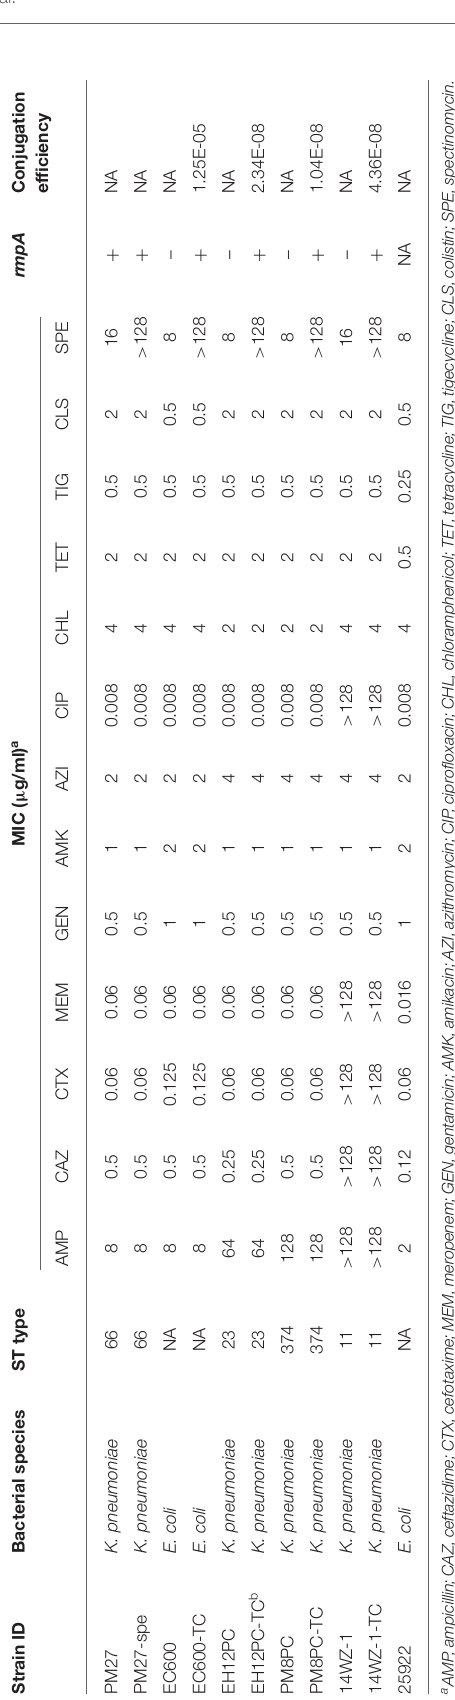
plasmid pPM27_Vir. The plasmid pPM27_Vir was found